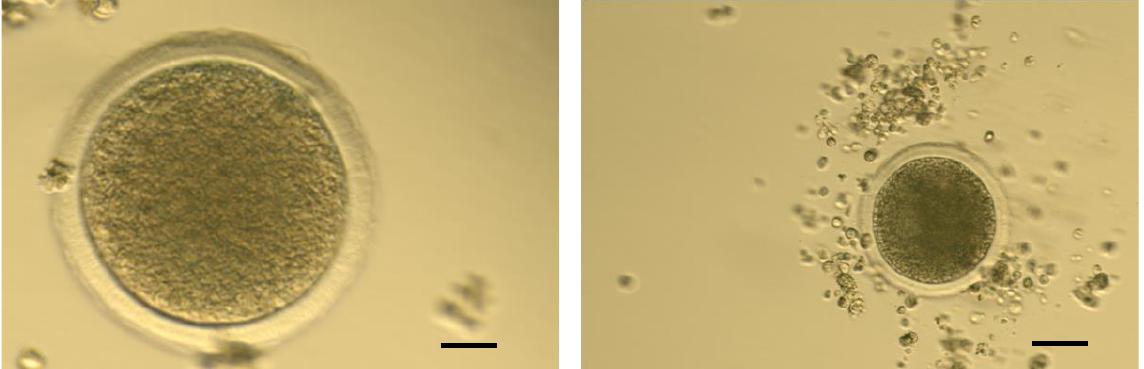
Figure 3 . Bovine oocytes after maturation (bar=100µm left, 50µm right).